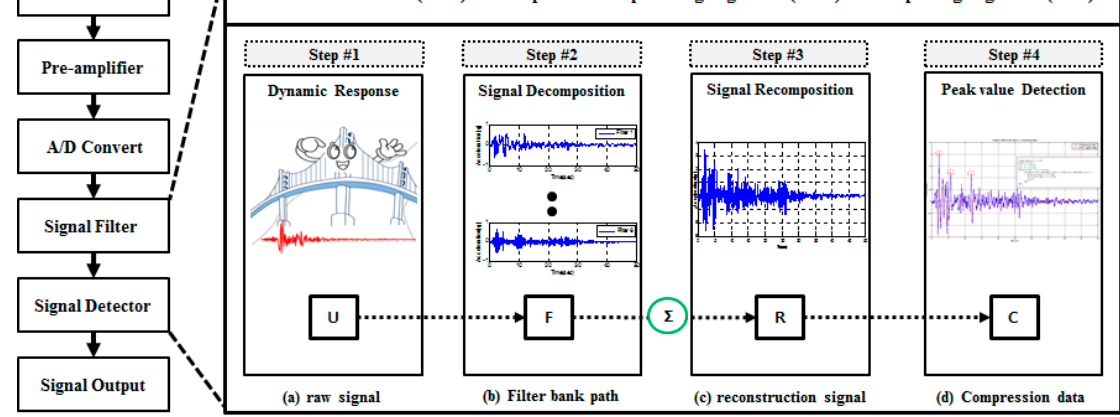
Figure 2. Mechanism of AFB for IDAQ system : ( a ) raw signal; ( b ) filter bank path; ( c ) reconstruction signal; ( d ) compression data